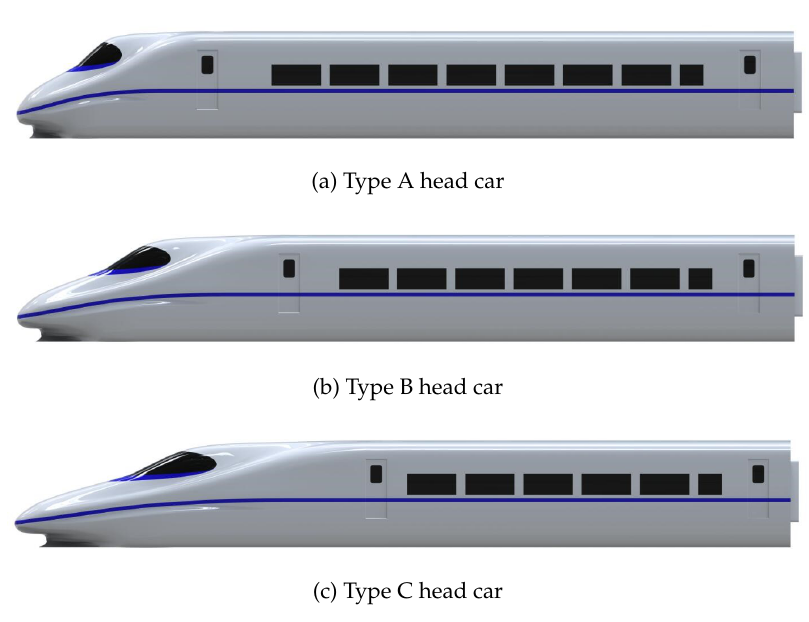
Fig. 2. Three calculation models of head car